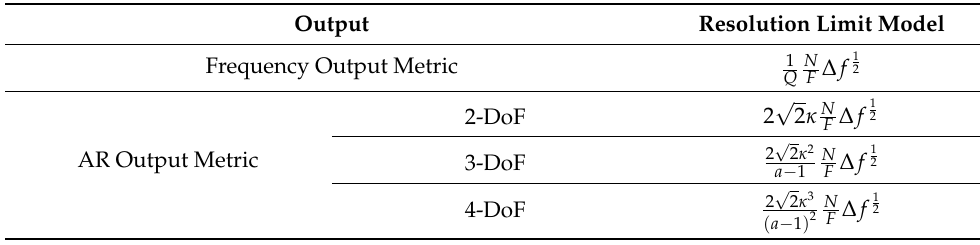
Table 6. Comparison of resolution limit model using frequency and AR output metrics. Adapted from